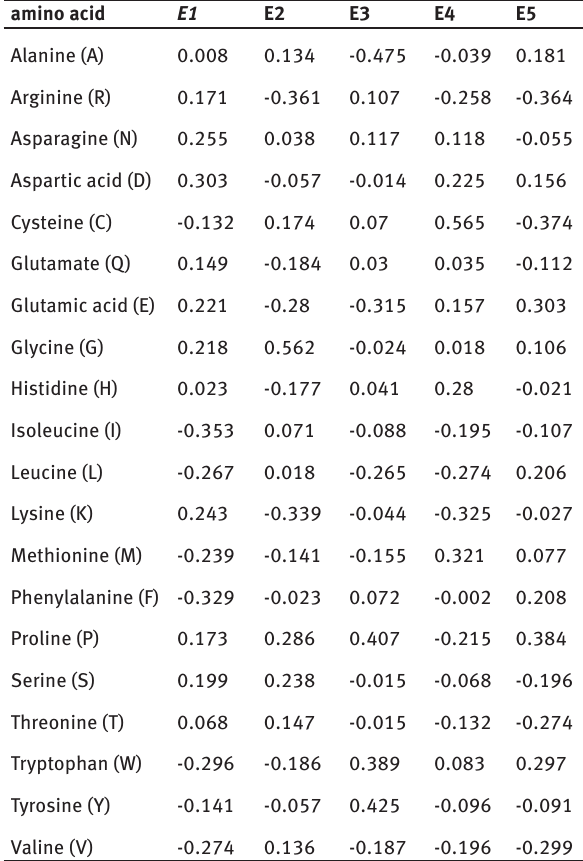
Table 1: E-descriptors of amino acids. amino